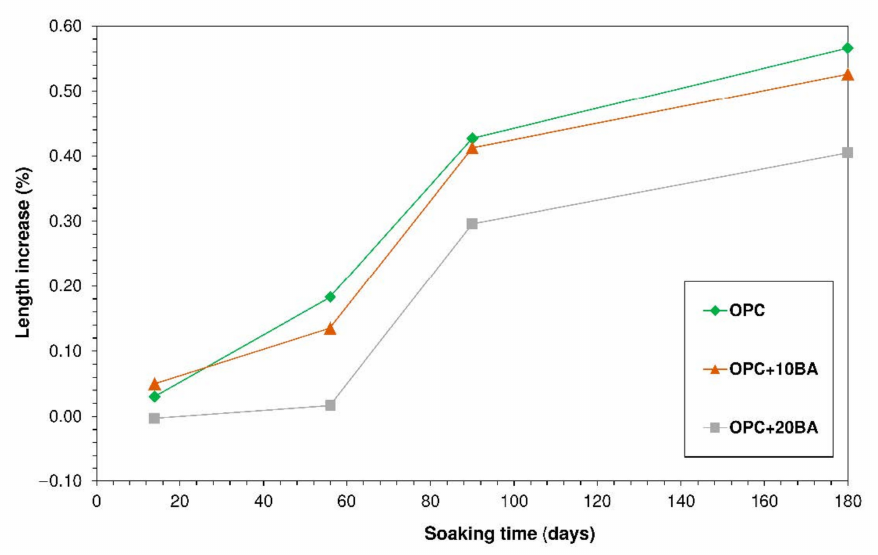
Figure 4. Expansion in cements exposed to Na 2 SO 4